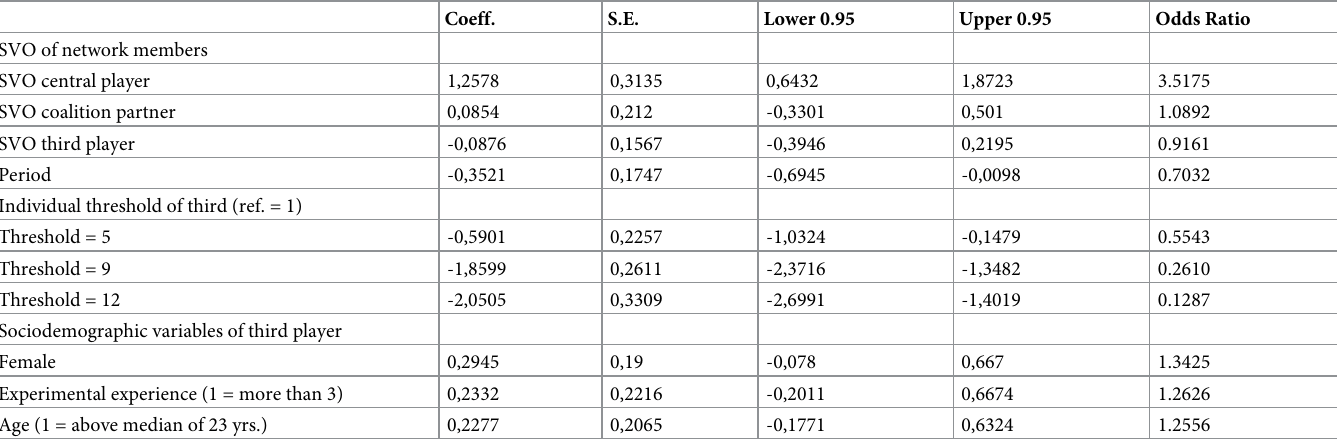
Table 3. Logistic regression of SVO, threshold and other controls on the probability of need satisfaction of the third player. Coeff.